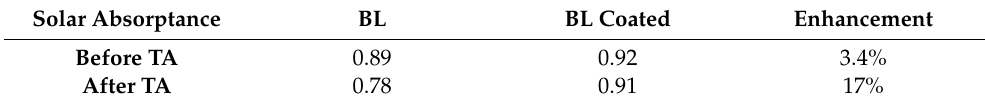
Table 2. Enhancement of solar weighted absorptance by deep black pigment coating. Table 2. E nhancement of solar weighted absorptance by deep black pigment coating. Solar Absorptance BL BL Coated Enhancement Solar Absorptance Before TA 0.89 0.92 After TA